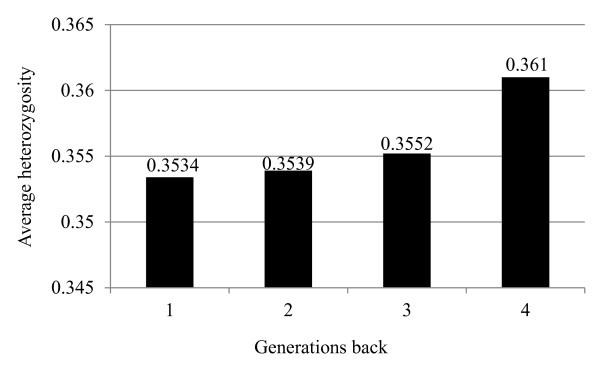
Average Heterozgosity for the last four generations traced back in the pedigree (generation interval = 5) in the pedigree of Holstein bulls.